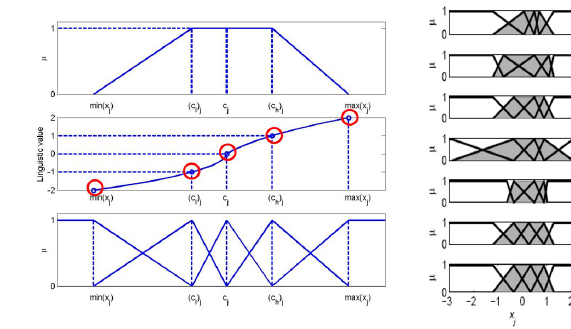
Figure 1: Nonlinear scaling and membership functions.